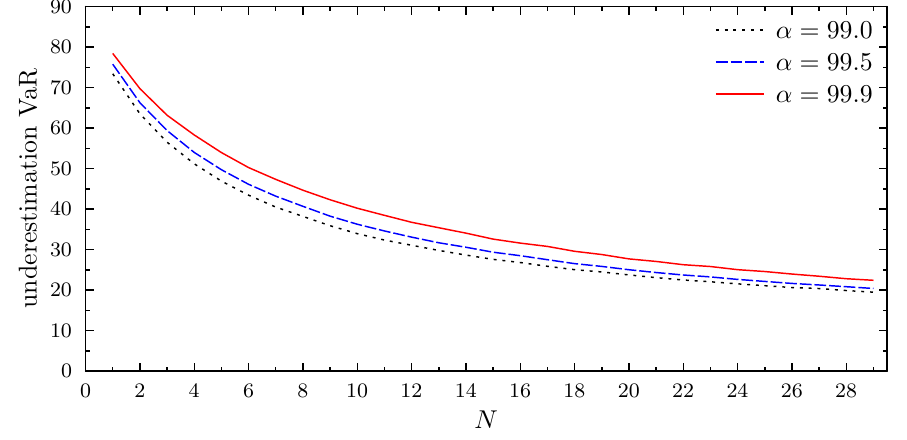
Figure 9. Underestimation of the VaR if fluctuating asset correlations are not taken into account. The empirical covariance matrix is used and compared for different values of N . Reproduced with permission from (Schmitt et al. 2015), Infopro